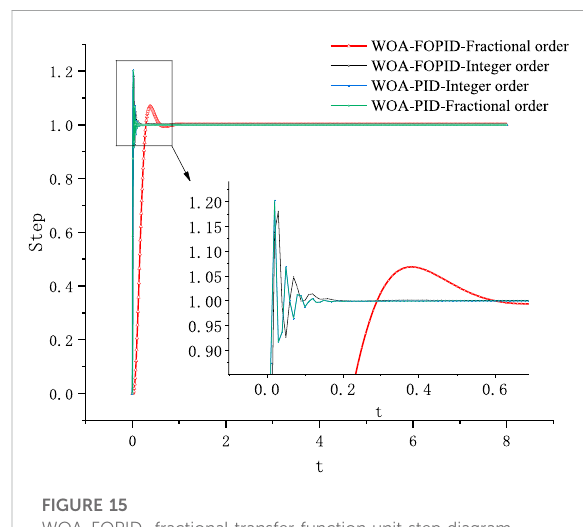
FIGURE 15 WOA-FOPID – fractional transfer function unit step diagram.